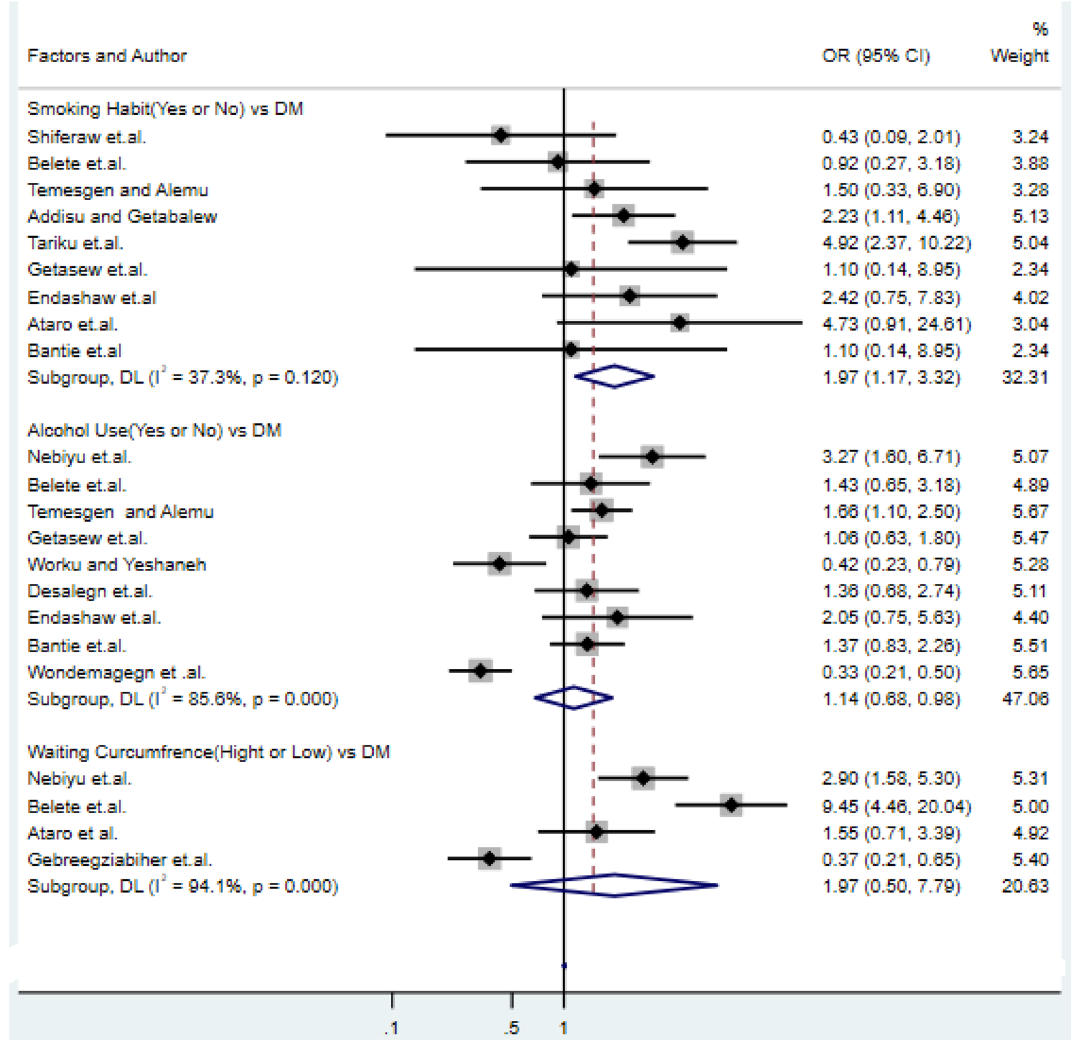
Figure 6. Forest plots of odds ratio for the association of smoking, alcohol consumption and wasting circumference with type-2